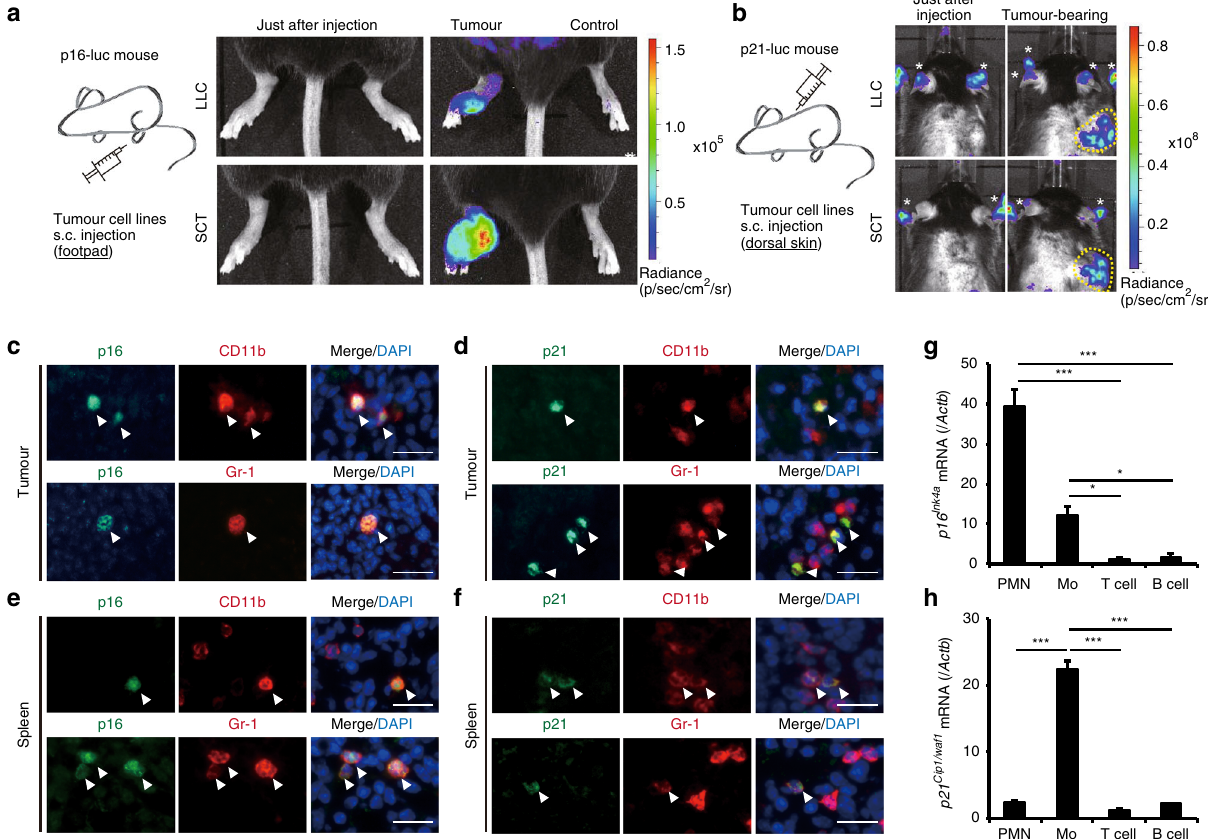
Fig. 1 Tumour-induced MDSCs express p16 Ink4a and p21 Cip1/Waf1 . a p16-luc mice were injected subcutaneously (s.c.) in the left footpad with LLC (3 weeks after injection; upper panels) or SCT (6 weeks after injection; lower panels) cells. The right footpad was injected with matrigel vehicle alone as a negative control. Representative bioluminescence images of mice just after tumour injection or tumour-bearing mice are shown. b Representative bioluminescence images of p21-luc mice that received s.c. injection of LLC (2 weeks after injection; upper panels) or SCT (4 weeks after injection; lower panels) cells in the dorsal area. Tumour areas are indicated by dotted circles; asterisks indicate signals from paws and ears. c – f Representative immunohistological images of tumour ( c , d ) and spleen ( e , f ) in an SCT-bearing mouse labelled with p16 ( c , e ) or p21 ( d , f ) antibodies (green) and either CD11b or Gr-1 antibodies (red). Arrowheads indicate p16- or p21-positive cells. Tissues were extirpated 3 weeks after SCT injection. Scare bars indicate 40 μ m. g , h Expression of p16 ( g ) and p21 ( h ) mRNA in splenic PMN-MDSCs (PMN), Mo-MDSCs (Mo), T cells and B cells from SCT-bearing mice at 3 weeks after inoculation, as determined by qRT-PCR ( n = 3); data are represented as the mean ± SEM. The statistical signi fi cance was determined by Student ’ s t- test; * p < 0.05, *** p